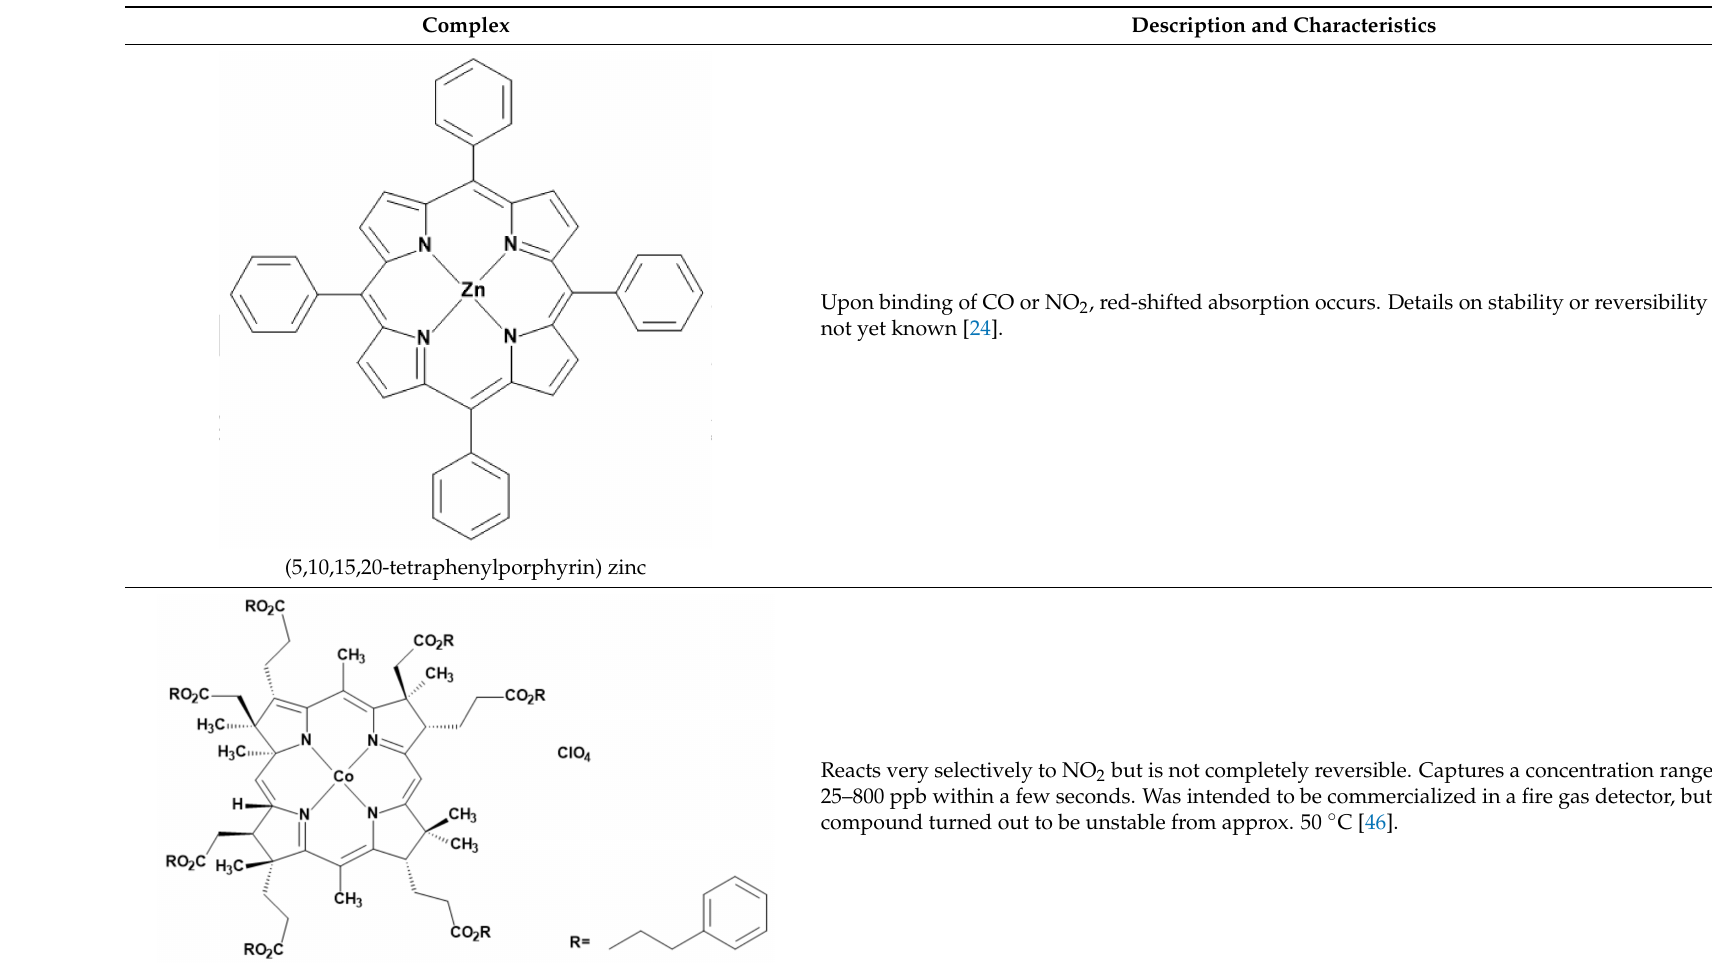
Table 3. Metal complexes for the detection of NO 2